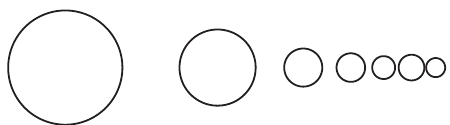
Figure 1: The set T is a disjoint union of countably many shrinking